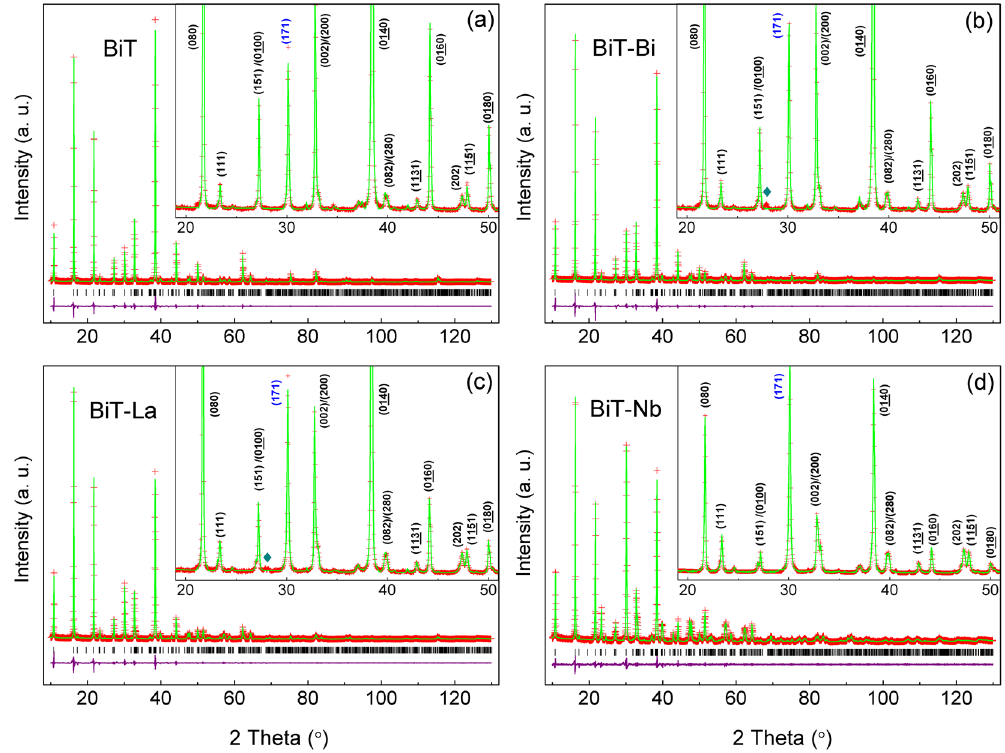
Figure 1. Powder diffraction refinements for ( a ) BiT, ( b ) BiT-Bi, ( c ) BiT-La, and ( d ) BiT-Nb ceramics. In ( b ) and ( c ), “ ♦ ” denoted as an impurity phase, Bi 2 O 3 .